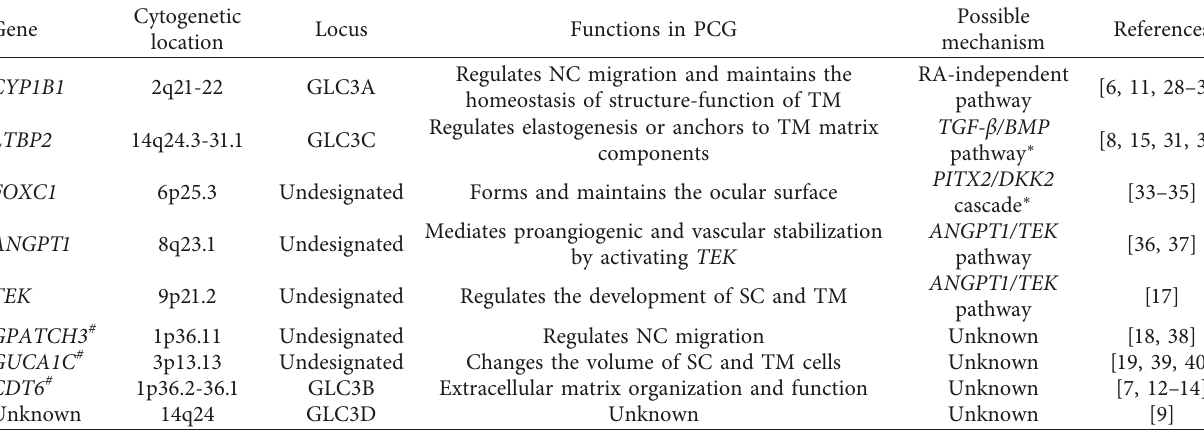
Table 1: Genes related to